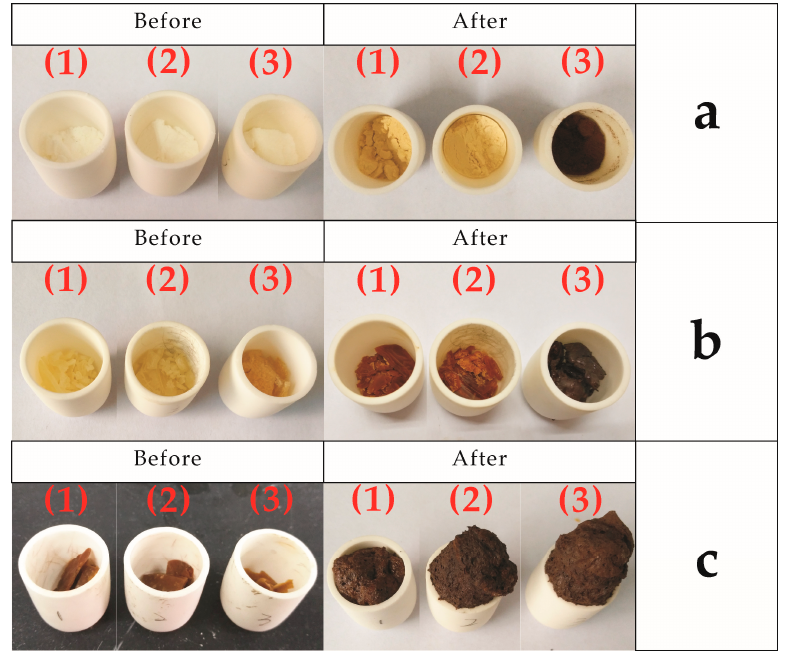
Figure 7. The images of non-treated: ( a ) water-treated; ( b ) and filtrate-treated; ( c ) starchesafter heated at 200 °C for 5 h: ( 1 ) CS; ( 2 ) HPS; ( 3 ) CMS.